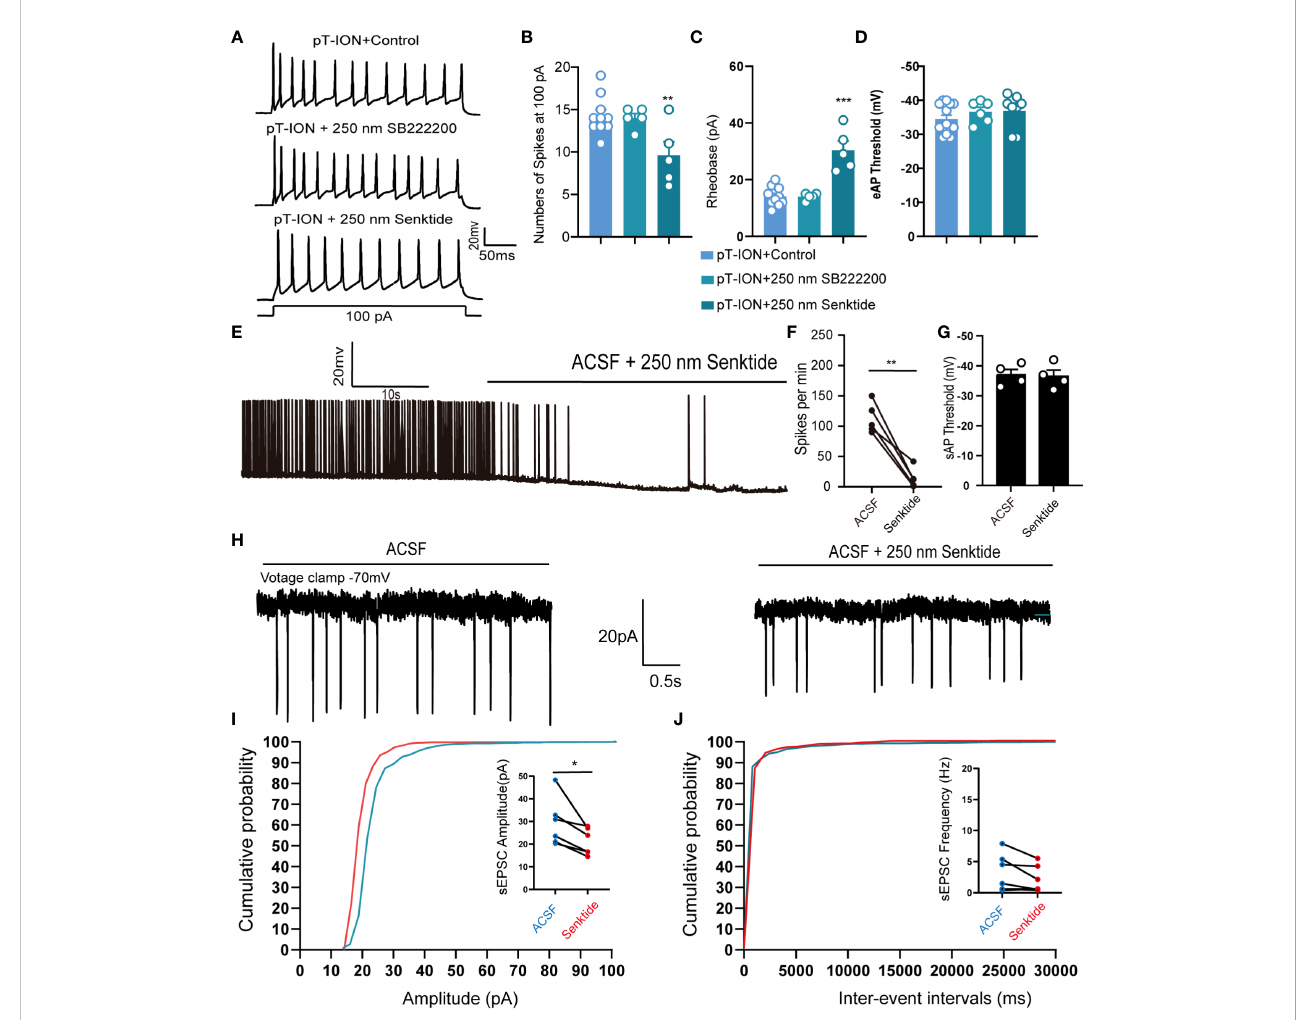
FIGURE 4 Pharmacological activation of NK3R in the LHb suppressed the pT-ION-induced abnormal excitation of neurons. (A) Patch-clamp recording showing the typical traces recorded from LHb neurons with SB222200 and senktide perfusion in pT-ION mice. (B – D) Data of evoked action potential fi ring spikes at 100 pA current stimulation (B) , rheobase (C) , and evoked action potential threshold (D) recorded from LHb neurons with SB222200 and senktide perfusion in pT-ION mice (**p < 0.01 vs. pT-ION+control, ***p < 0.001 vs. pT-ION+control, n = 10 neurons from 5 mice in the control group, n = 5 neurons from 5 mice in the SB222200 group, n = 5 neurons from 5 mice in the senktide group). (E) Typical traces of spontaneous action potential fi ring spikes recorded from LHb neurons with senktide perfusion in pT-ION mice. (F, G) Data of spontaneous action potential fi ring spikes (F) and spontaneous action potential thresholds (G) recorded from LHb neurons with senktide perfusion in pT-ION mice (**p < 0.01 vs. arti fi cial cerebrospinal fl uid, n = 5 neurons from 5 mice). (H) Typical frequency and amplitude of sEPSCs of LHb neurons with senktide perfusion in pT-ION mice. (I, J) Corresponding cumulative distributions and quanti fi cation of sEPSC amplitudes (I) and frequency (J) of LHb neurons with senktide perfusion in pT-ION mice (*p < 0.05 vs. arti fi cial cerebrospinal fl uid, n = 6 neurons from 4